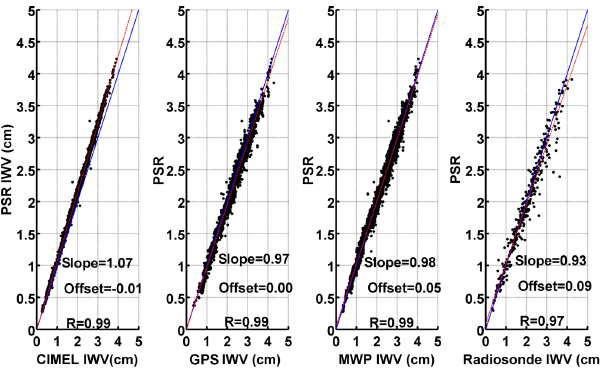
Figure 11. IWV retrievals from PSR using the spectral approach in the 934–948nm region, compared to synchronous ones of CIMEL, GPS, MWP and radiosonde, for the full 2-year measuring